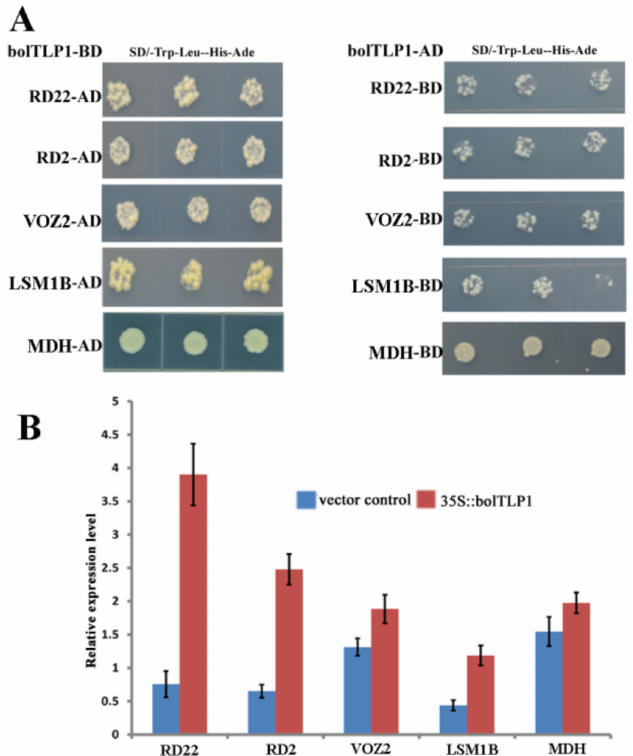
Figure 8. Identification and expression profiles of proteins interacting with bolTLP1. ( A ): Identifica- tion of proteins interacting with bolTLP1 by yeast two-hybrid assay. Three spots from left to right in each row indicated the 1:10 gradient dilution of yeast clone. ( B ): Relative expression levels of the five candidate genes, which encode proteins that interact with bolTLP1, in 35S:: bolTLP1 broccoli (35S::bolTLP1) and the vector control plants (vector